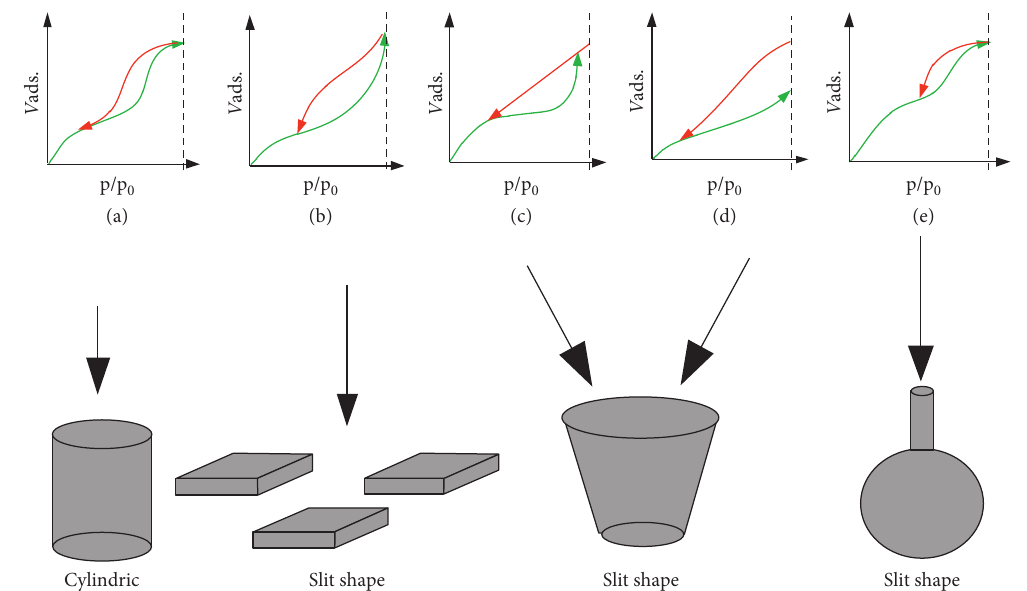
Figure 8: Hysteresis loop and its corresponding pore shape.